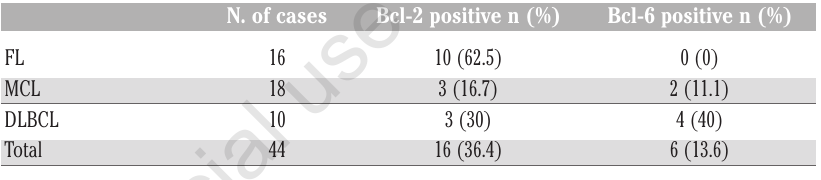
Table 1. Details of Bcl-2 and Bcl-6 expression in different groups of chronic B cell neo- plasms. N. of cases